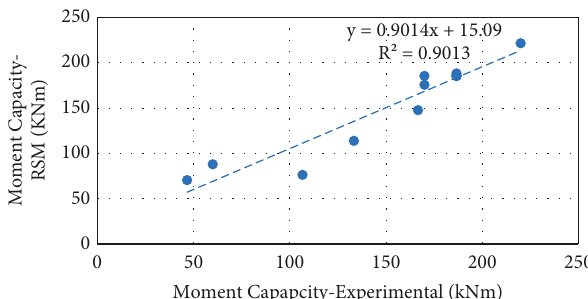
Figure 6: Predicted and actual values of moment